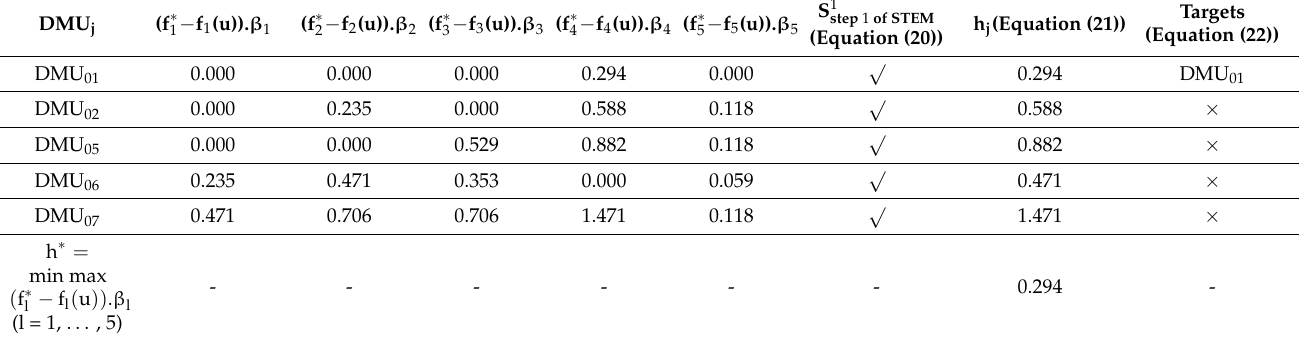
Target finding of non-radial FDH model 14 for DMU 07 in the second case study First, step 1 of STEM (p = 1) should be considered. By applying the first target finding stage, DMUs of feasible region (in step 1 of STEM model) were found. As described in Section 3.2.2, DMUs belonging to the feasible region should be found. In DMUs of feasible x ij ≤ 1, i = 1, 2, and regions, two conditions should be satisfied. At first, constraints x io y in Table A8, only DMU 01 , DMU 02 , DMU 05 , DMU 06 and DMU 07 satisfied these constraints. − f ( u )) . β } ≥ 0, l = 1, . . . , 5 should be satisfied Moreover, the constraints max l { ( f ∗ l l l for each DMU of feasible region (the second condition). Checking the second condition for DMU 01 , DMU 02 , DMU 05 , DMU 06 and DMU 07 are shown in Table A10. As shown in Table A10, the constraints of the second condition were also satisfied for DMU 01 , DMU 02 , DMU 05 , DMU 06 = { DMU } . and DMU 07 . So, S 1 01 , DMU 02 , DMU 05 , DMU 06 , DMU 07 step 1 of STEM Table A10. Applying the first and second target finding stages to find targets of step 1 of STEM (p = 1) for DMU 07 (the second case study). DMU